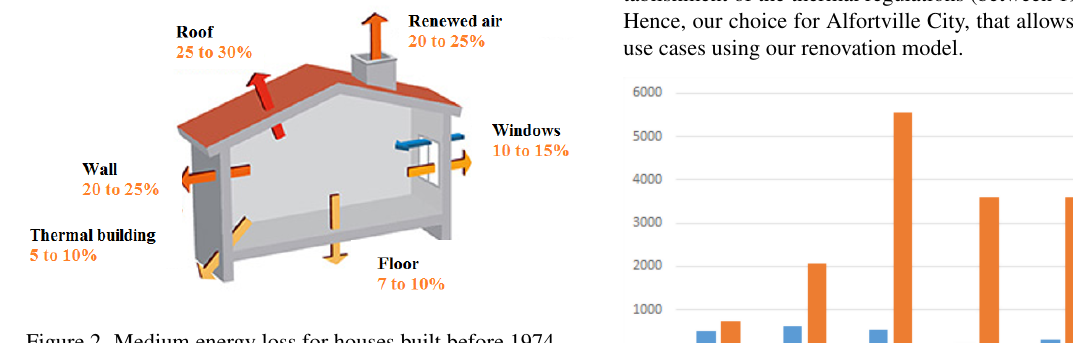
Figure 2. Medium energy loss for houses built before 1974